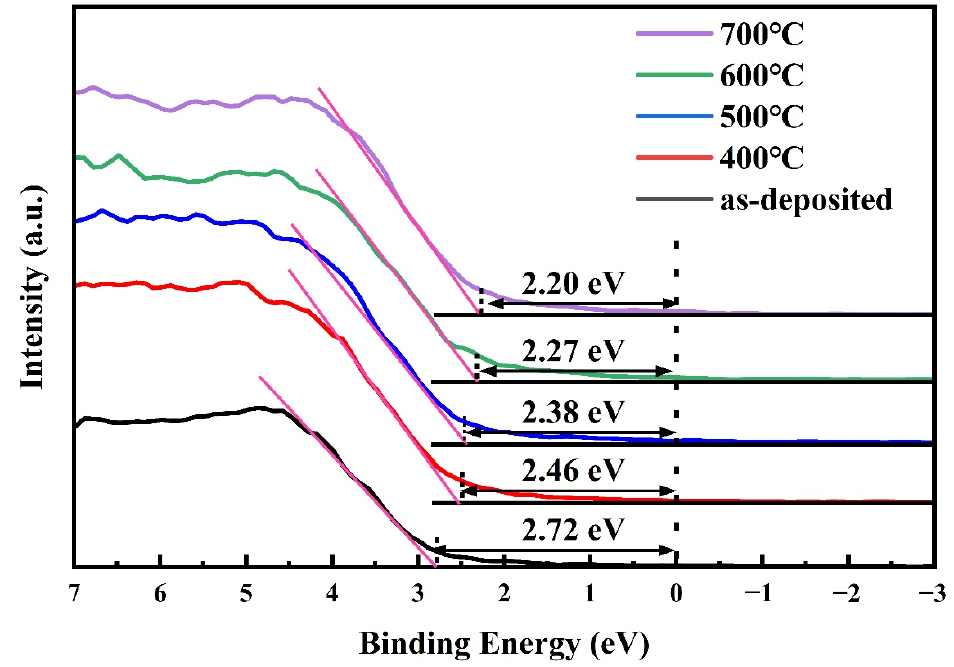
Figure 11. VB spectra of lanthanum-doped HfO 2 films at different temperatures.